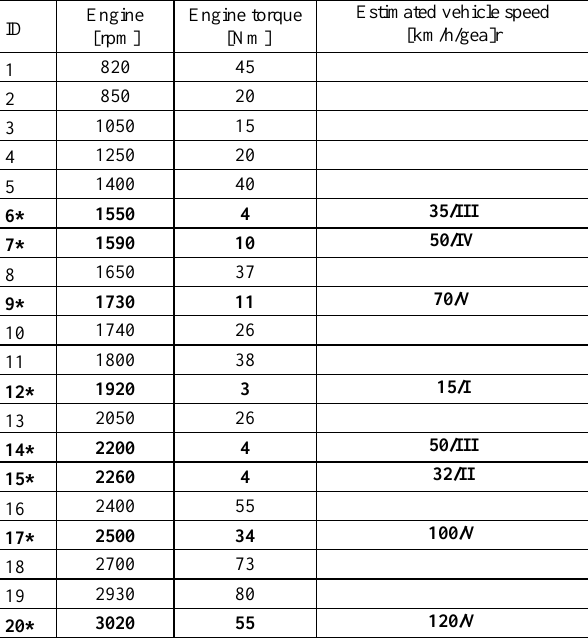
Table 7. Measurement points according to EUDC testing